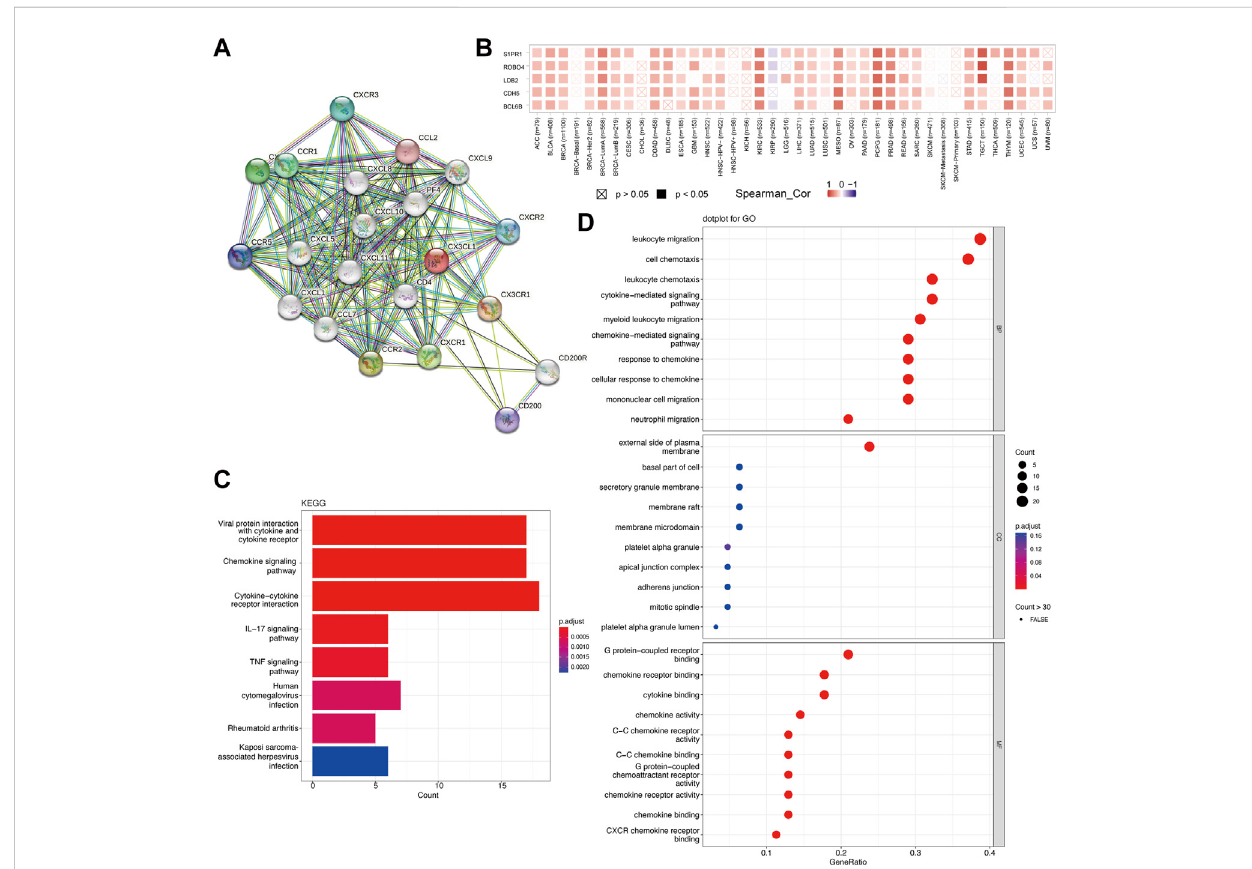
FIGURE 6 Functional enrichment analysis of CX3CL1 related genes. (A) Protein-protein interaction (PPI) network of 20 experimentally determined CX3CL1- interacting genes obtained from the STRING database. (B) The correlation heatmap showing the association between CX3CL1 expression level and CDH5, ROBO4, LDB2, BCL6B, and S1PR1 in various cancer types. (C) The bar plot of the Kyoto Encyclopedia of Genes and Genomes (KEGG)-enriched terms based on CX3CL1-interacting and CX3CL1-related genes. The column colors showed the signi fi cance of the adjusted p -value. (D) The dot bubble of gene ontology (GO)-enriched terms based on the two gene datasets, including biological process (BP), molecular function (MF), and cellular component (CC). The color of the dot indicated the signi fi cance of the adjusted p